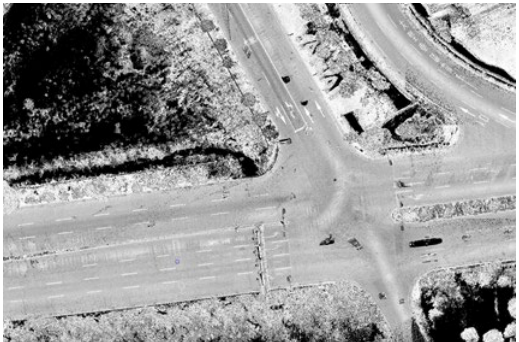
Figure 6. Intensity map from the 3D point cloud data